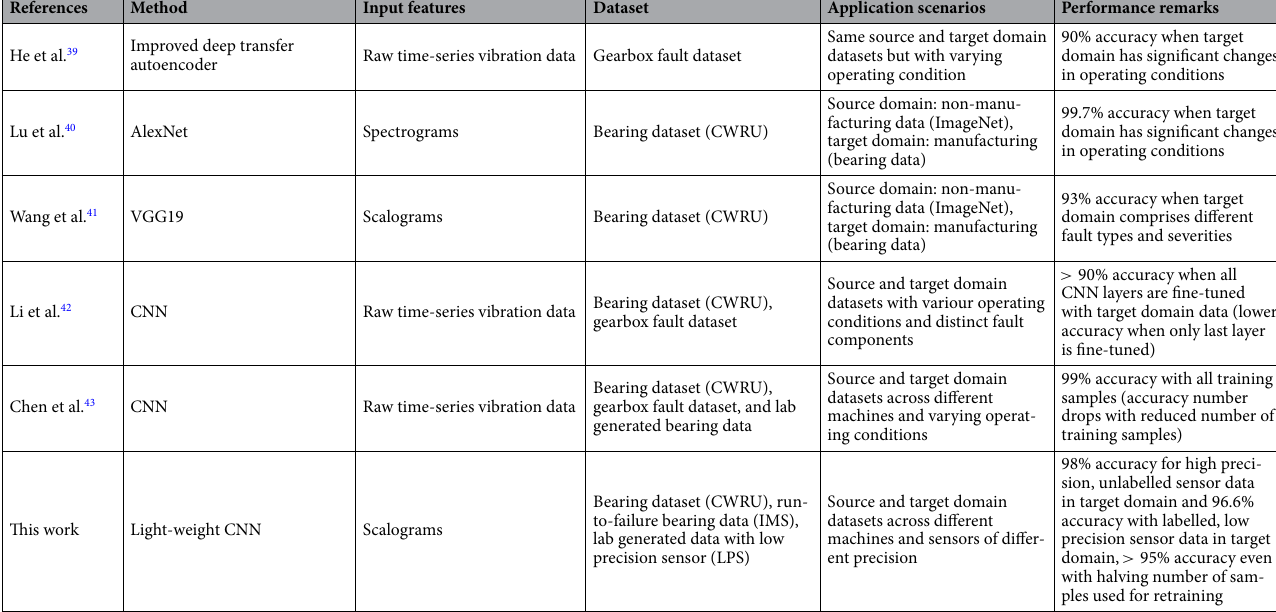
Table 4. Comparison of the proposed work with other parameter-based transfer learning methods used for domain generalisation for efficient machine fault